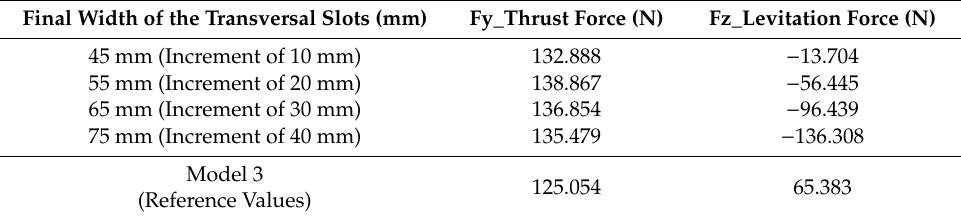
Table 3. Average value of thrust force and levitation force.